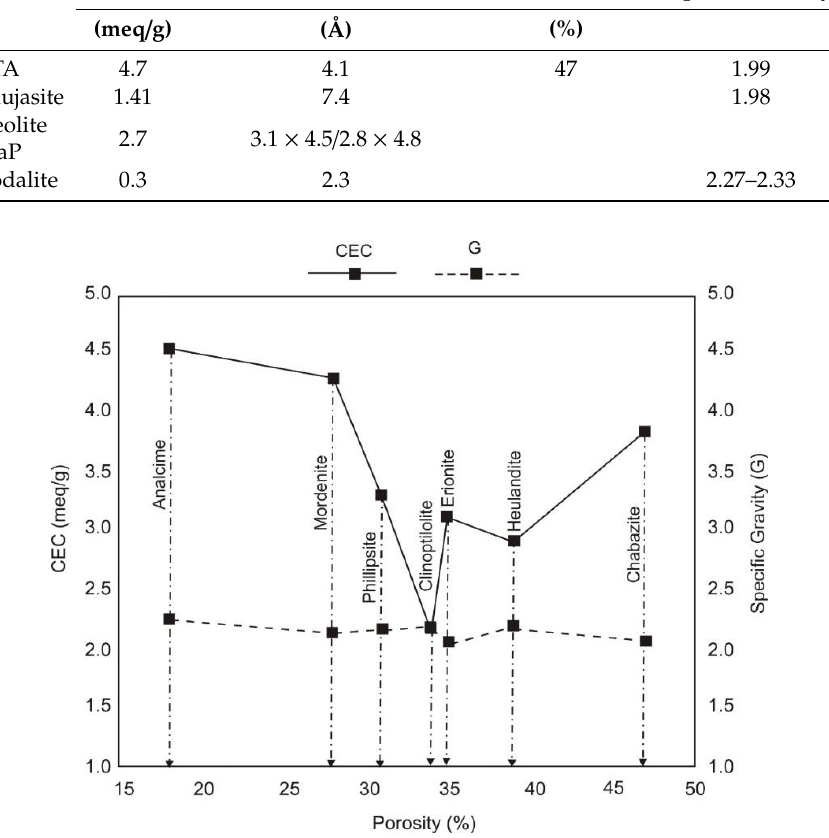
Table 1. Properties of some commonly available synthetic zeolite formed from fly ash.